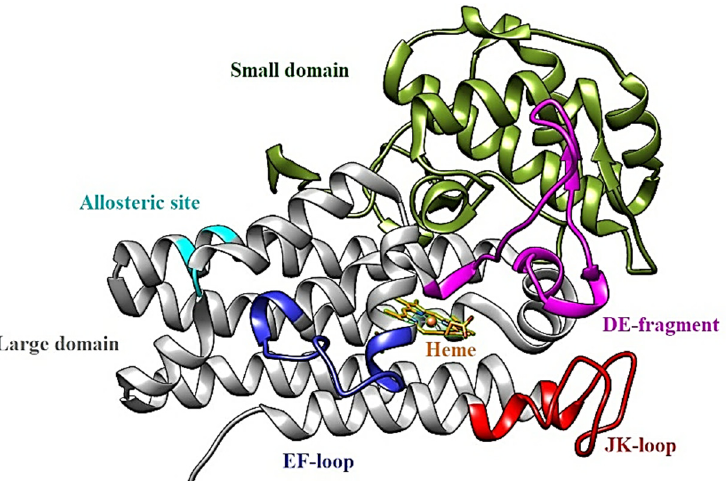
Figure 2. Structure of indoleamine deoxygenase 1 (IDO1) with highlighted regions: minor domain (green) and major domain (grey, magenta, red, blue, and cyan). Contained in the larger domain are: the DE fragment, composed of the DE hairpin and the DE loop; JK loop; EF loop; the heme cofactor (orange); the allosteric site.